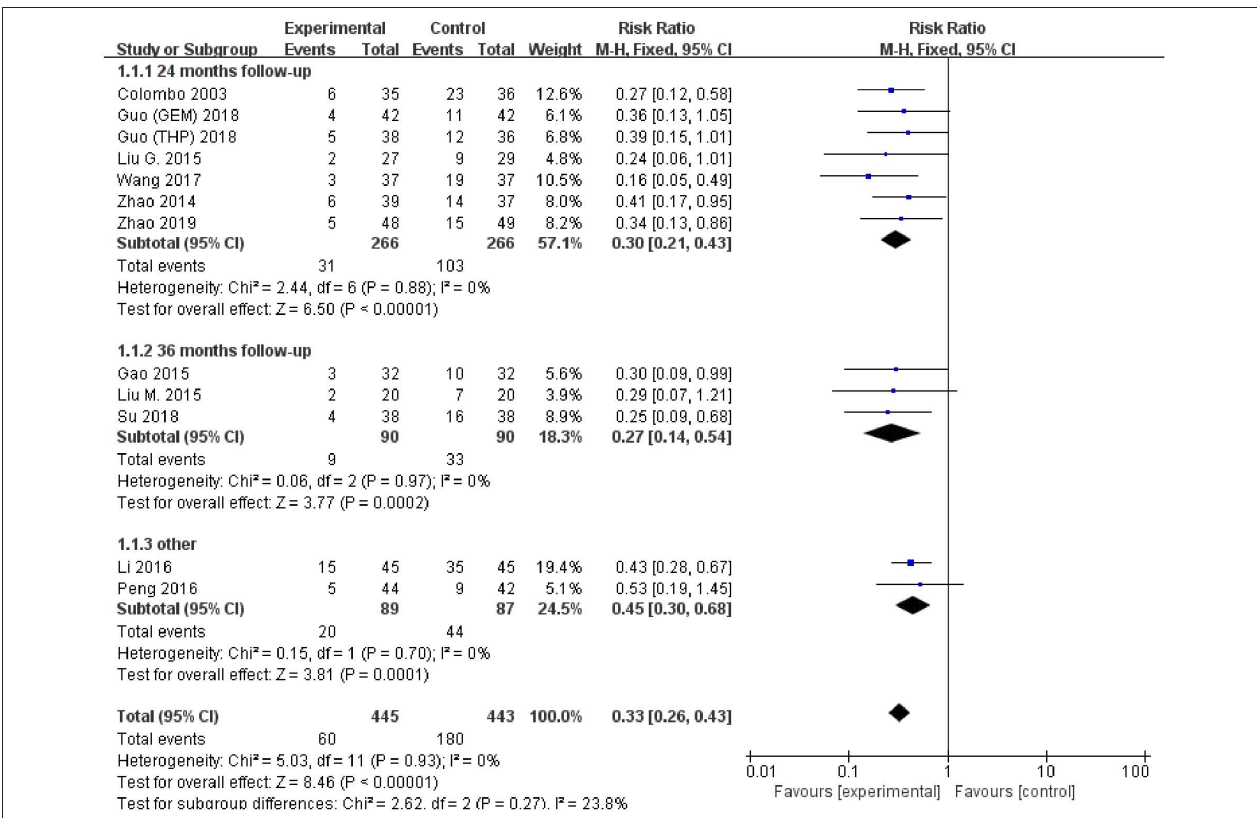
FIGURE 3 | Forest plot of recurrence rate comparing thermal intravesical chemotherapy with normal temperature intravesical chemotherapy in different follow-up groups.